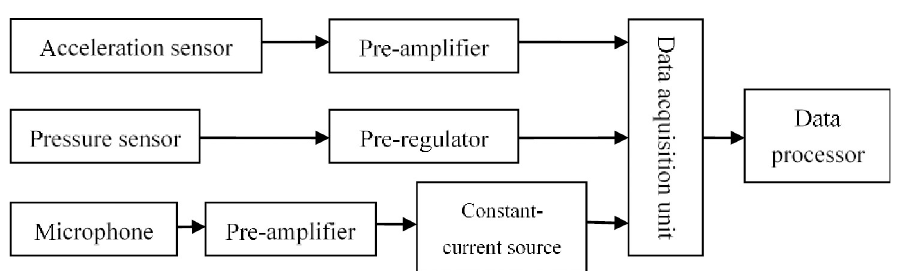
Fig 2. Sketch of signal measurement system working